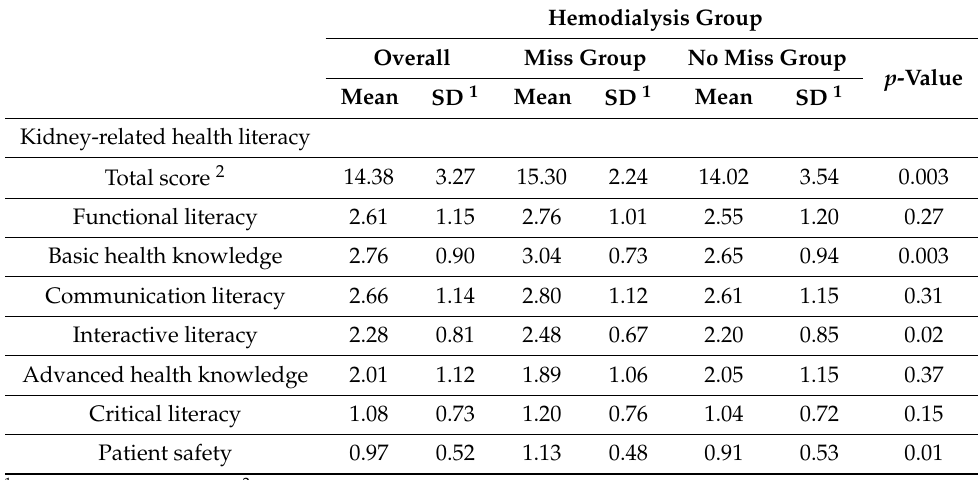
Table 2. Kidney-related health literacy among the study participants.